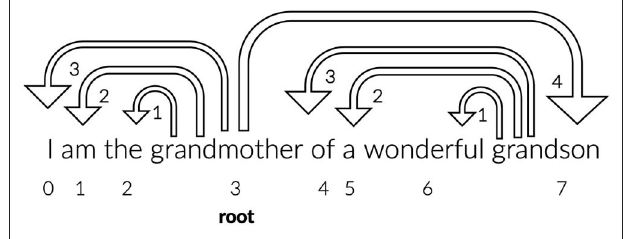
FIGURE 1 | The dependency parsing of the sentence “I am the grandmother of a wonderful grandson” is depicted. The ids of the words, representing the position of the words in the sentence, are indicated with numbers 0–7 and the word “grandmother” is identified by the parser as the root word. The arrows have the direction from the head/root word to the dependent/children, the dependency distance between the pair is indicated on the arrow head and equals the difference of their id values. The words “the,” “am,” “I,” and “grandson” are dependent from the word “grandmother” and the words “wonderful,” “a,” and “of” are dependent from the word “grandson.” The MDD of this sentence based on the Equation (11) equals (3+2+1+4+3+2+1)/7 = 2.28.